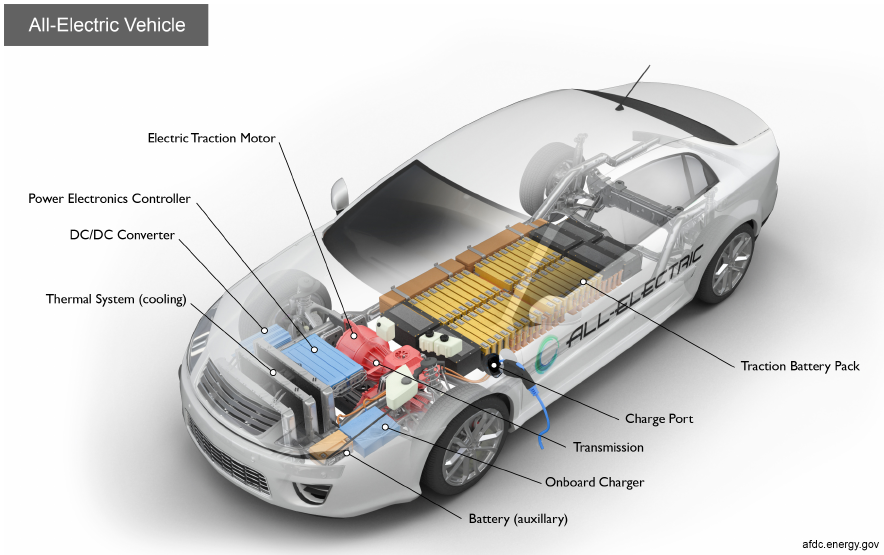
Figure 2. Typical components in an all electric